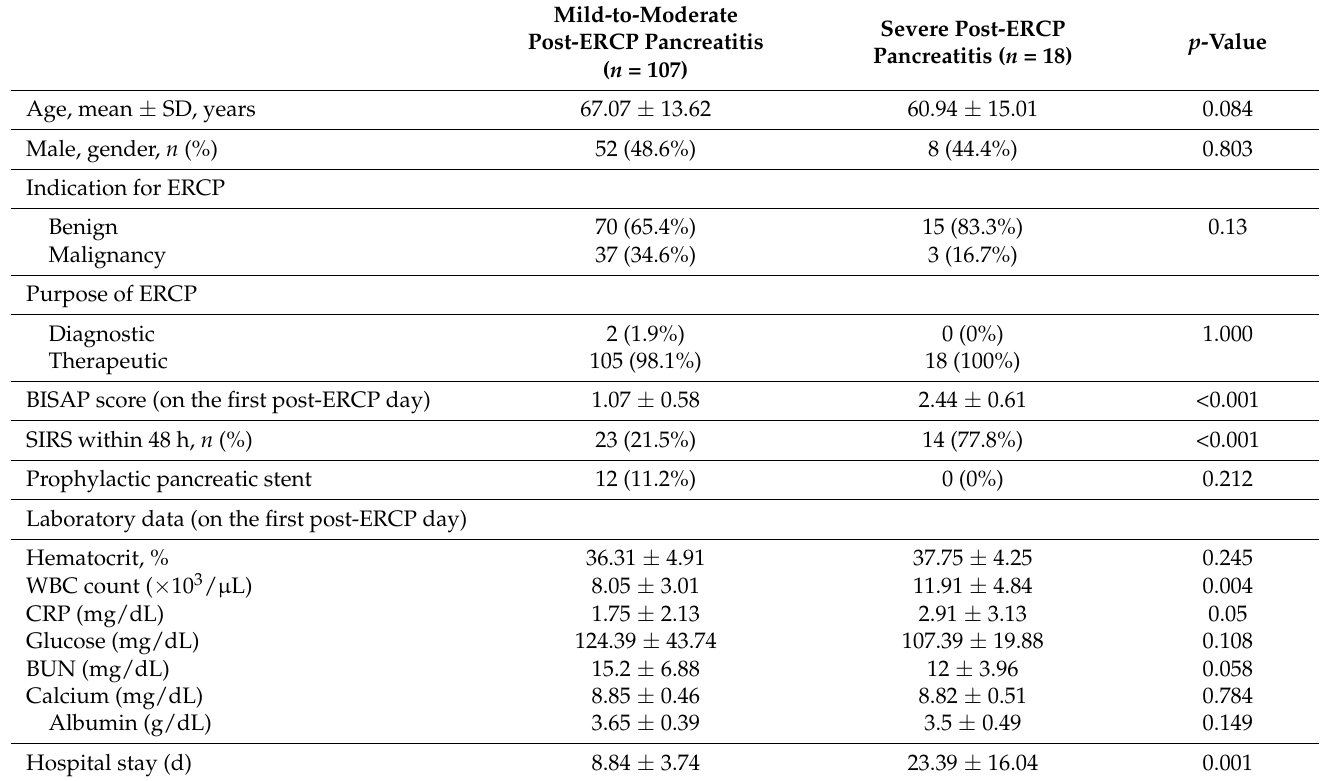
Table 1. Demographic and clinical characteristics of 125 patients diagnosed with post- ERCP